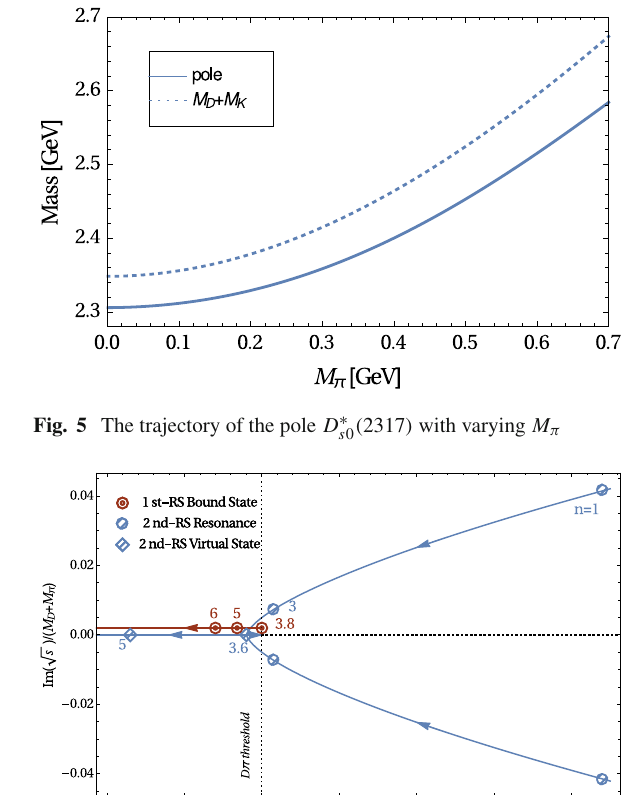
Fig. 6 Thetrajectoryofthepolearound2 . 1GeVforthesingle-channel ( S , I ) = ( 0 , 1 / 2 ) with varying M